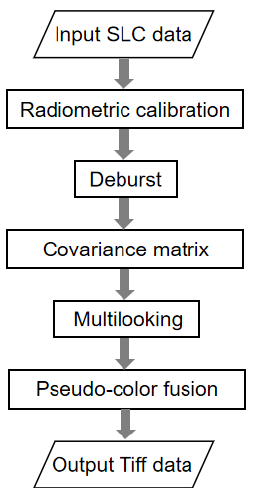
Figure 2. Preprocessing flow of the original Sentinel-1 imagery.